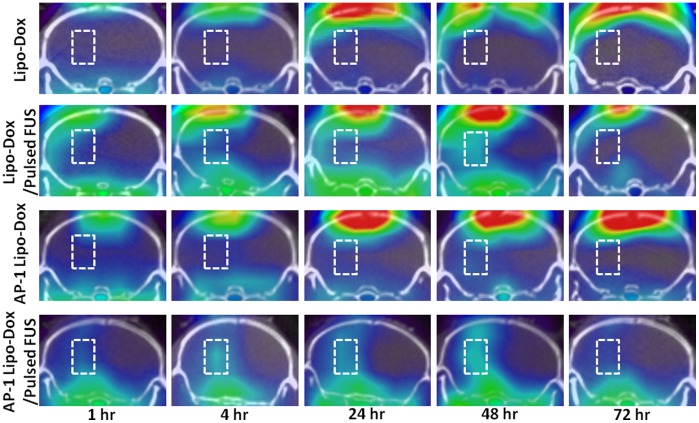
Micro-SPECT/CT axial images of GBM-bearing mice at 1, 4, 24, 48 and 72 hr after intravenous injection of 500 µCi/0.1 mL of targeted or untargeted 111In-doxorubicin liposomes.Brain tumors and contralateral normal brain are in the left and right hemispheres, respectively. The regions-of-interest (ROI) for tumors are indicated by rectangles in the left hemispheres. There was a clear radioactivity at 1, 4, 24, and 48 hr in the ROI of mice treated with AP-1 Lipo-Dox followed by pulsed FUS (bottom row).